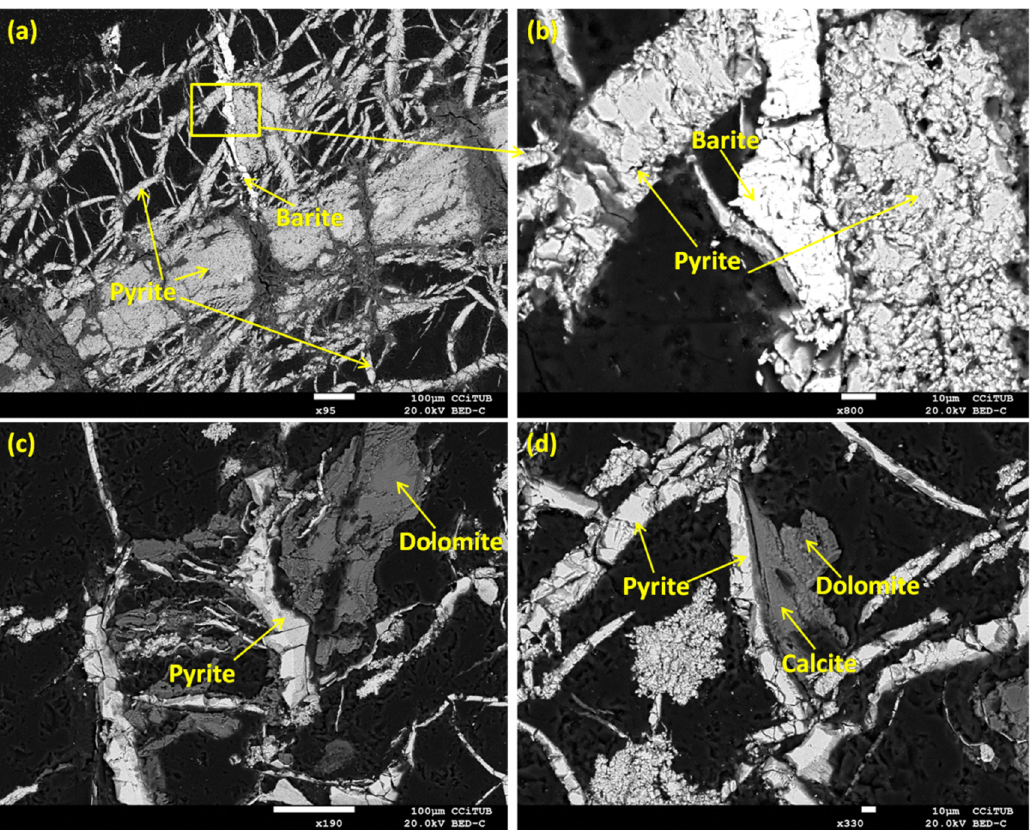
Figure 13. SEM back-scattered electron images of pyrite, barite, dolomite, and calcitein the Jinhuashancoals. ( a ) Massive pyrite infilling of epigenetic cleats, cross-cutby cleat-filling barite veins; ( b ) Enlargement of yellow square in ( a ); ( c ) Cleat-filling pyrite and dolomite; and ( d ) Pyrite, calcite, and dolomite as cleat infillings.